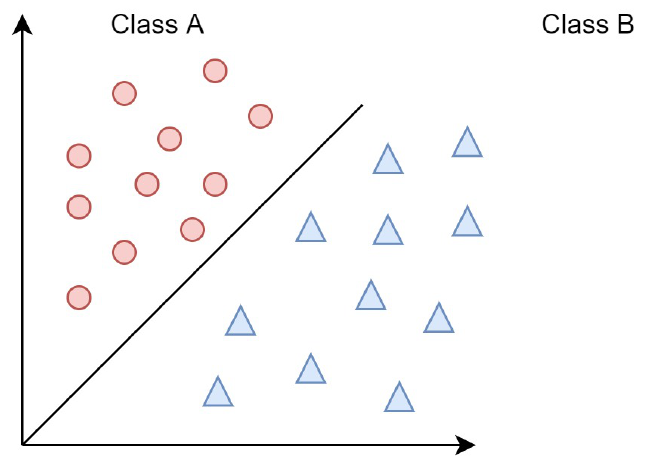
Figure 6. Data classification.